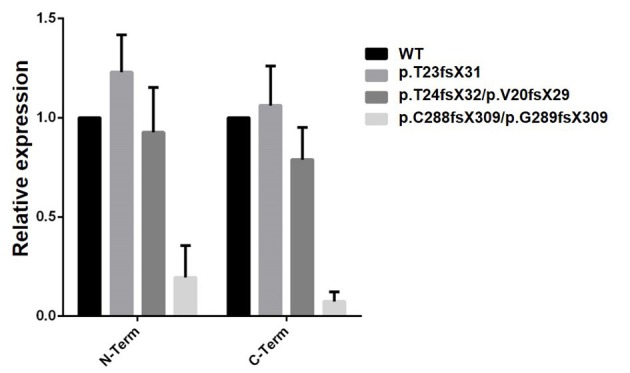
Analysis of WT and mutant cell clones by qRT-PCR.Two independent primer sets in 5’ (N-ter) and 3’ (C-ter) parts of the gene were used. Transcript instability is noted for the cell clone carrying a mutation in exon 9, but not for the two clones located in exon 3. An alternative Ift80 transcript has been annotated, which is initiated at an internal ATG codon and lacks the first 137 amino acids, which encodes the first half of BP1. This transcript lacks the IFT38 binding domain, thereby encoding a likely non-functional protein, and explaining why the exon three mutations do not lead to transcript instability.